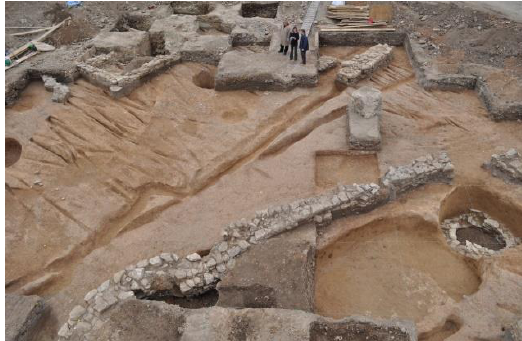
Figure 7. Kutná Hora (Central Bohemia), former Jesuit College. Advance archaeological excavation in 2011 and 2012 following the preparatory stage (survey probes, collection information about older finds). Silver mining workplace from 13 th – 15 th